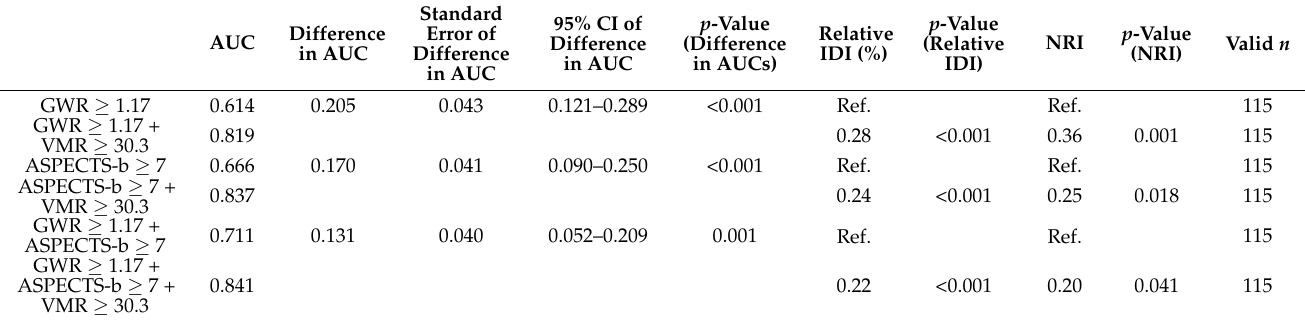
Table 3. Comparisons of AUCs, IDI, and NRI for predicting good CPC at 1 month using CT methods and TCD-VMR